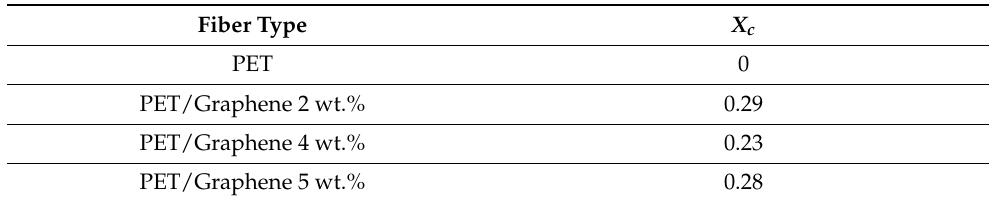
Table 1. Degree of crystallinity of all PET/graphene and pristine PET fibers with ≈ 550 µ m diameter size, as determined from WAXS analysis.